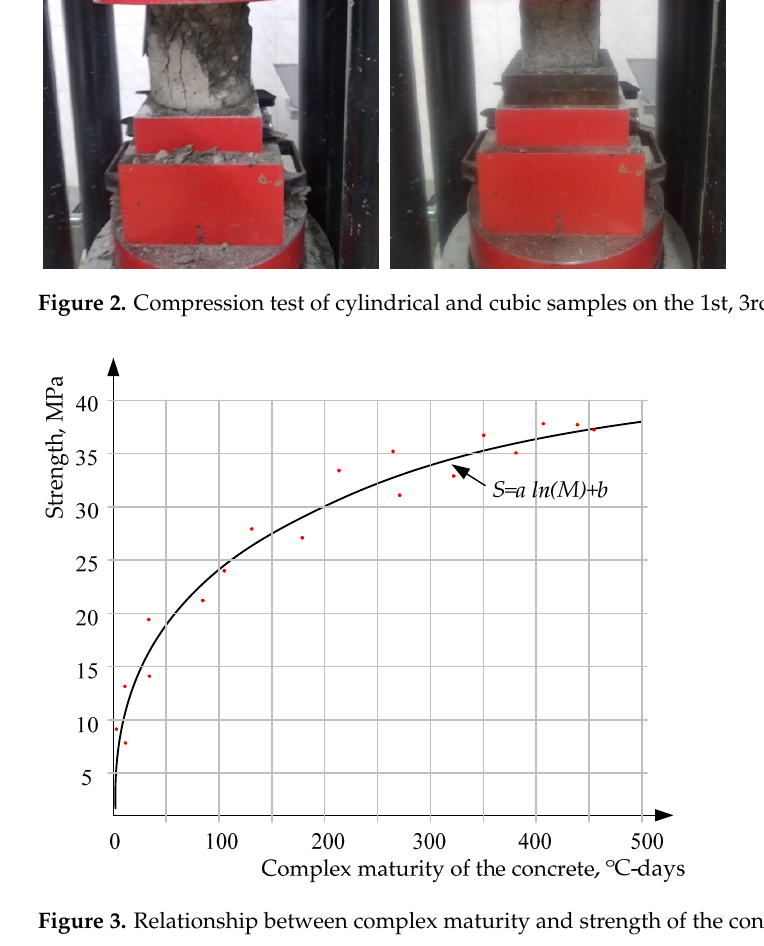
Figure 2. Compression test of cylindrical and cubic samples on the 1st, 3rd, 7th, 14th and 28 th days.